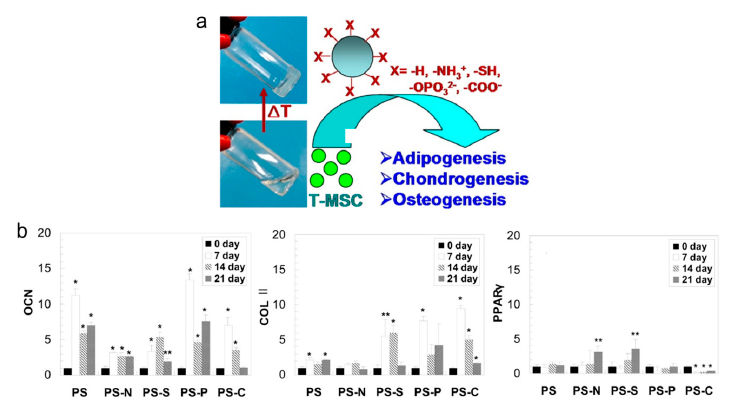
Figure 5. ( a ) Schematic of controlling specific differentiation of TMSCs by adding surface-modified microspheres in PEG-L-PA thermogels; ( b ) OCN, Col II, PPAR γ expression of TMSCs were analysis in 3D cultured thermogel, * and ** indicate p < 0.01 and p < 0.05 by Student t -test (reproduced with permission from [30]).